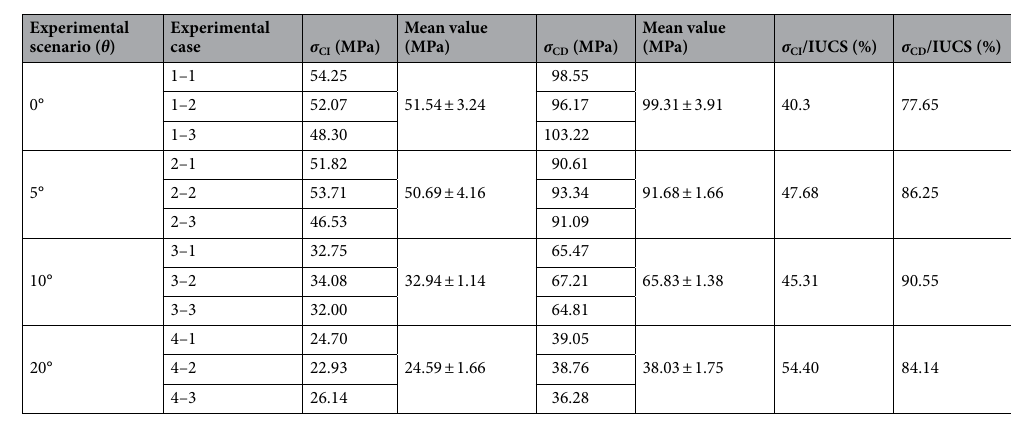
Table 5. CI and CD thresholds determined by AE energy and their ratio to corresponding peak compression strength of granite specimen at various inclination angles.